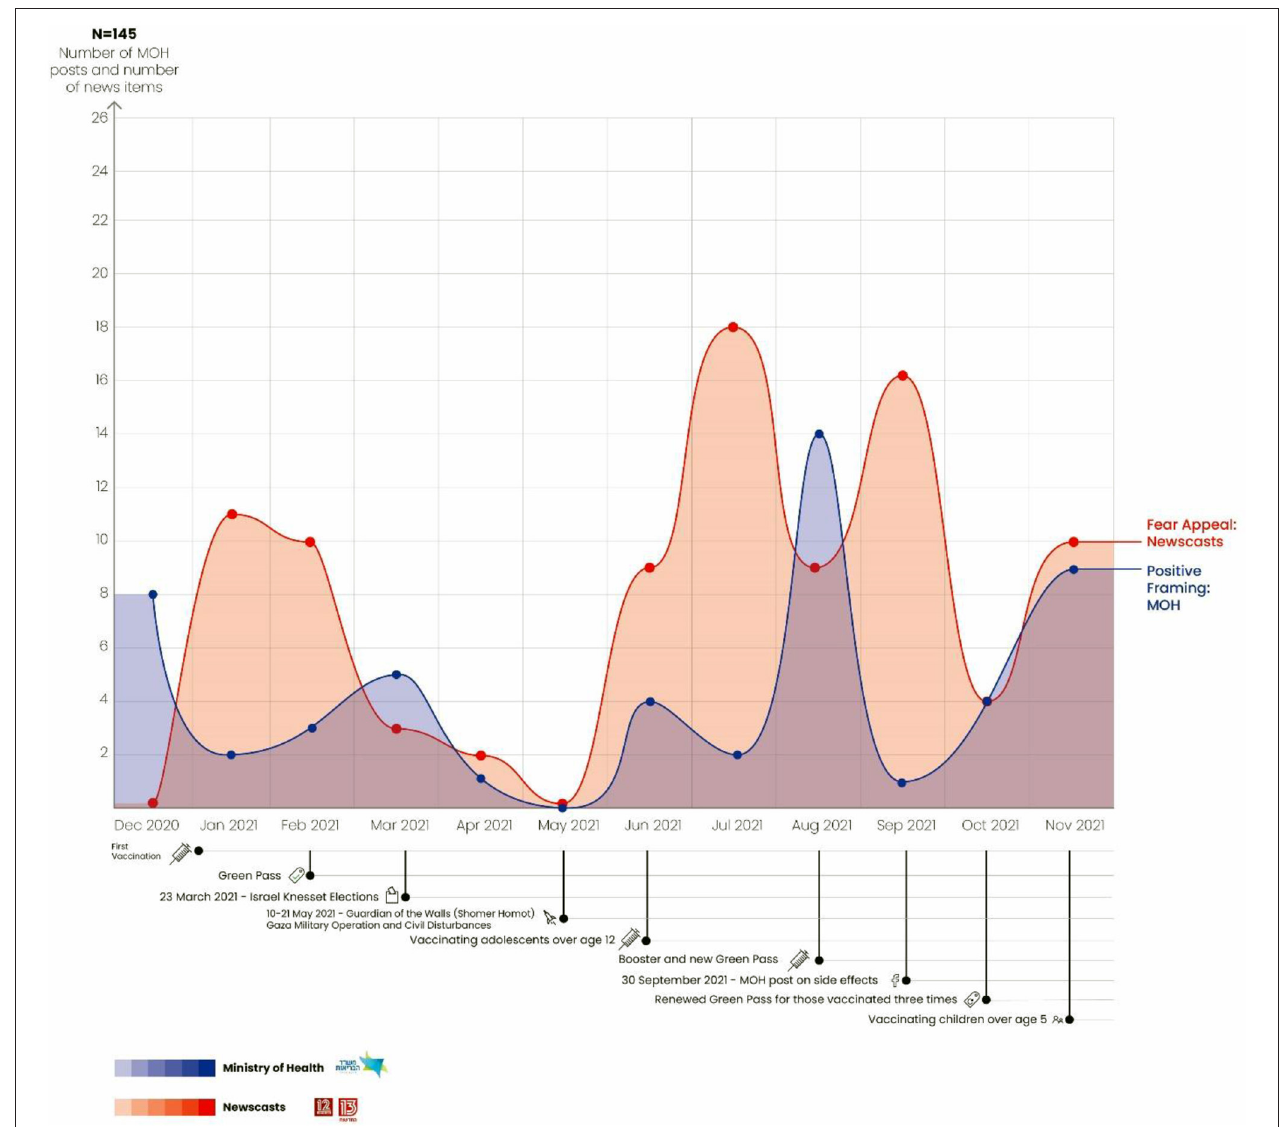
FIGURE 3 | Use of fear appeal strategy on the news vs. MOH’s use of positive framing